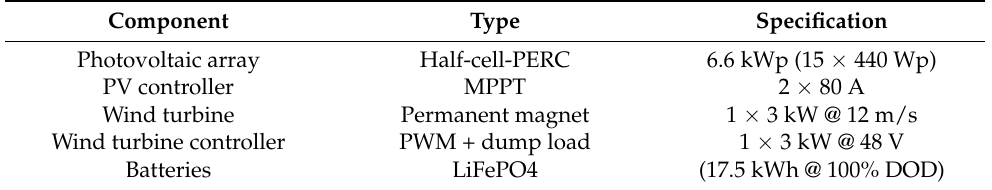
Table 5. Upgraded microgrid component